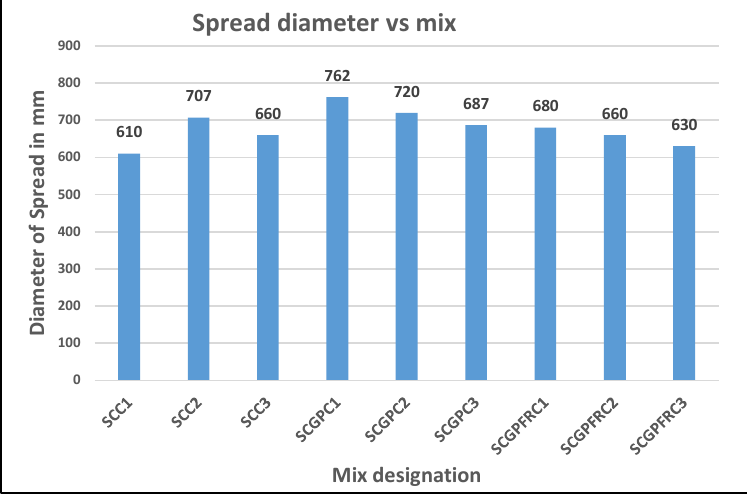
Fig. 4. Graph showing the variation of T 50cm value for all